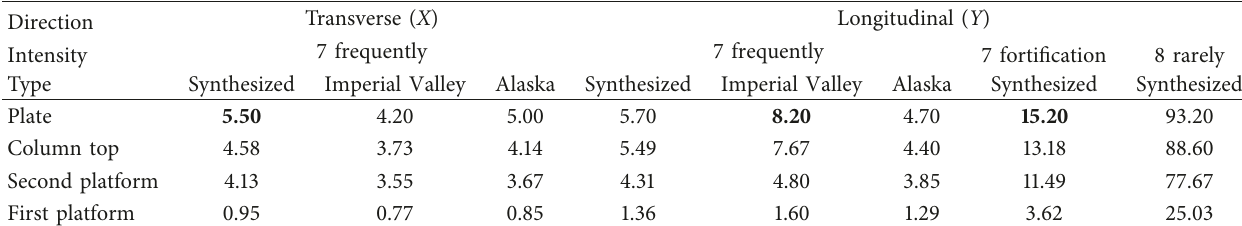
Table 4: The maximum displacement of different locations in foundation